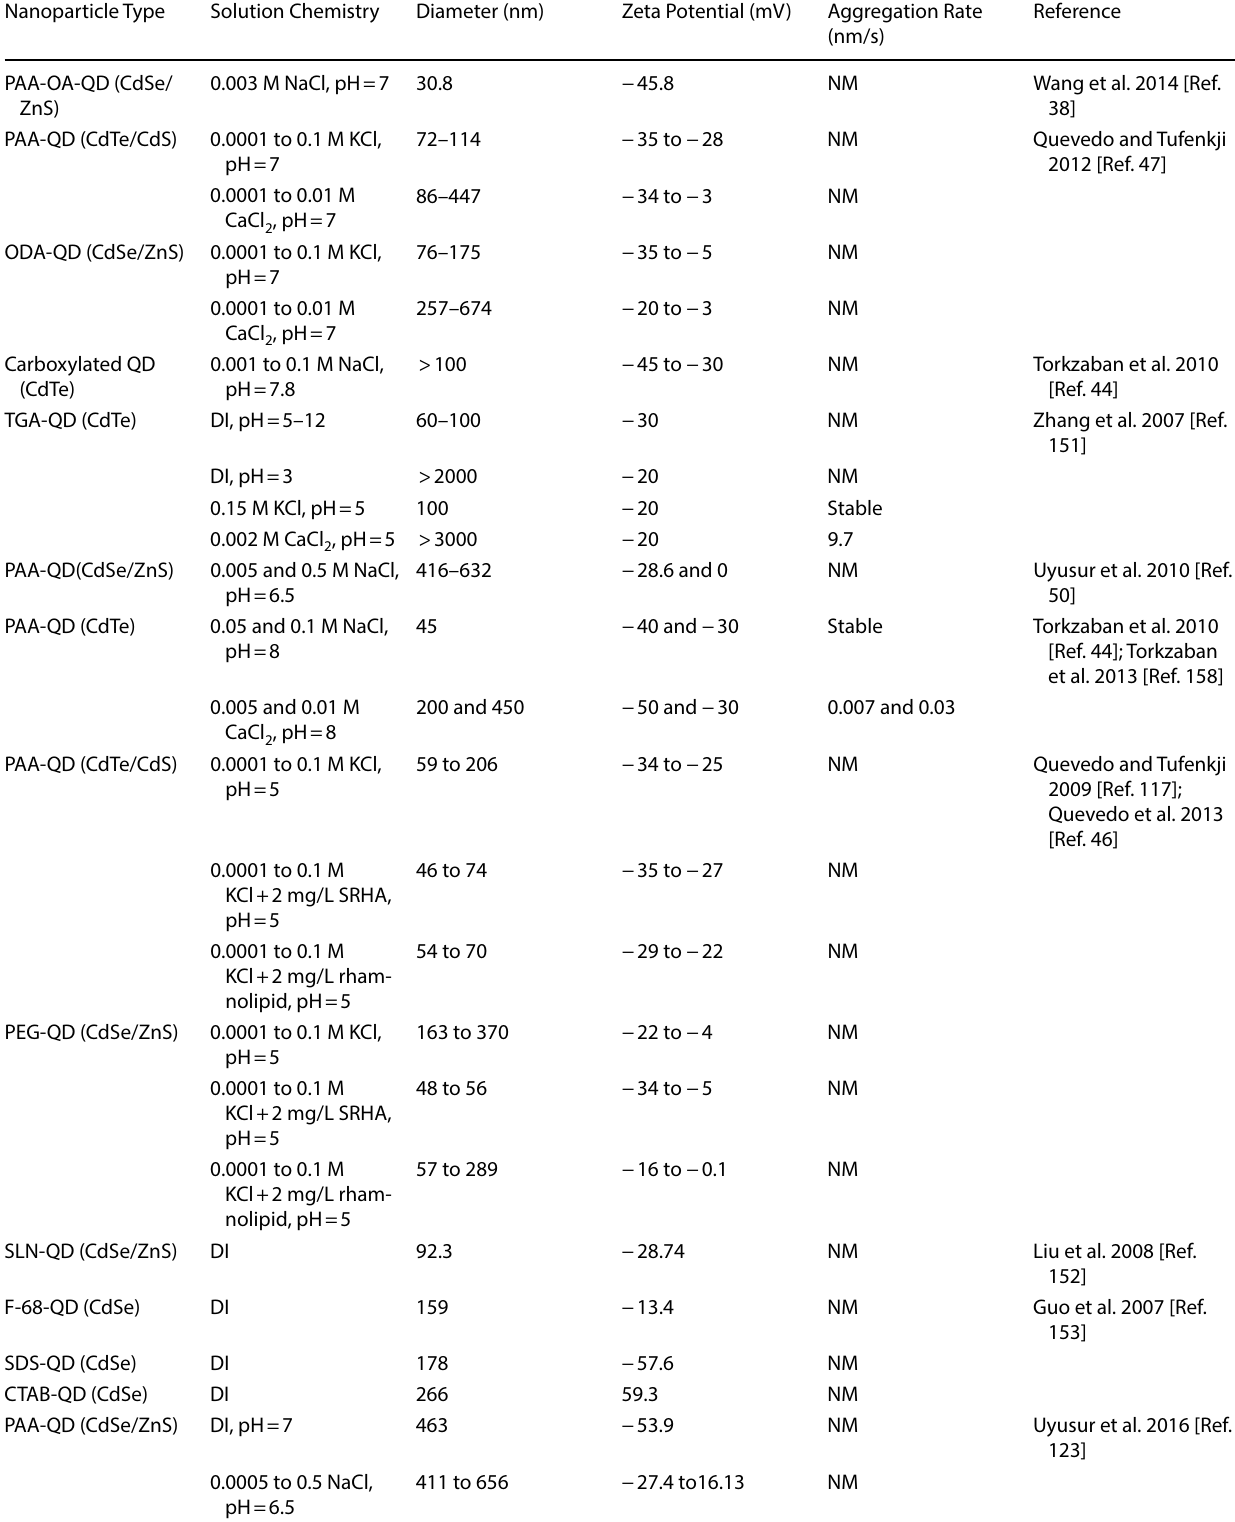
Table 4 Summary of characteristics of QDs measured by DLS in the